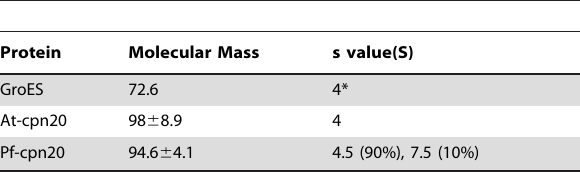
Table 2. Analytical ultracentrifugation values for GroES, At- cpn20 and